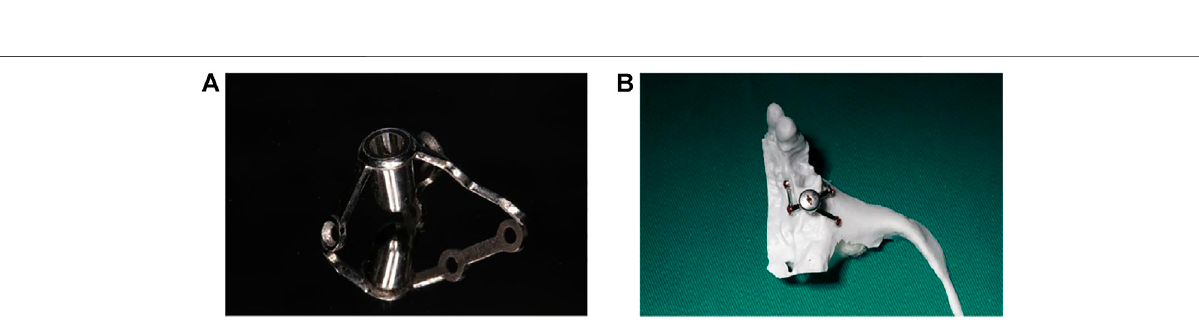
( Figure 3B ). Design the upper part of the short implant as an implant platform shaped as a frustum of a cone with a slope of 45 ° and height of 1 mm ( Figure 3C ). Use an inverted round table hole with a morse taper, an inner hexagonal hole, and a